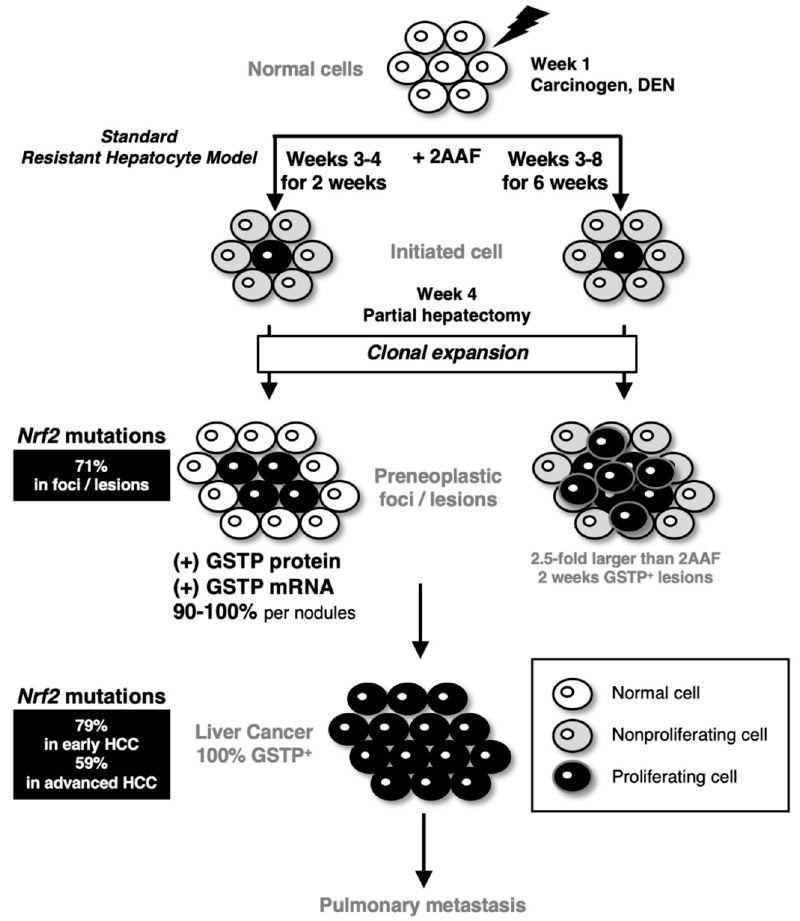
Figure 6. Hepatocarcinogenesis and NRF2 activation in the resistant hepatocyte model.